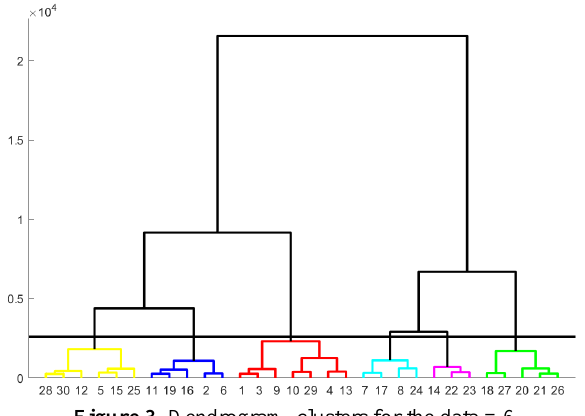
Figure 3 . Dendrogram, clusters for the data = 6.